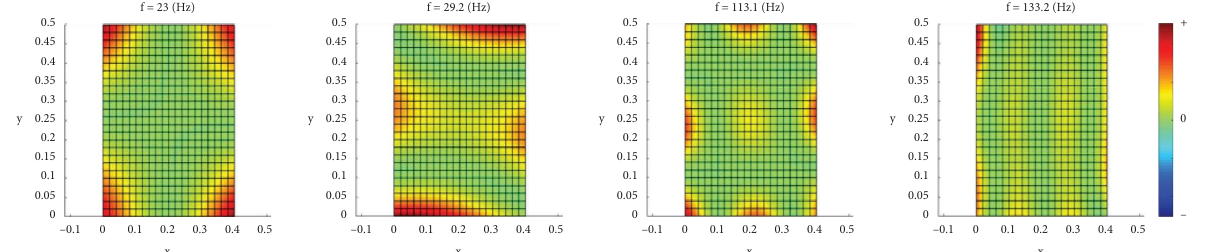
Figure 10: Mass sensitivity analysis at four chosen frequencies.